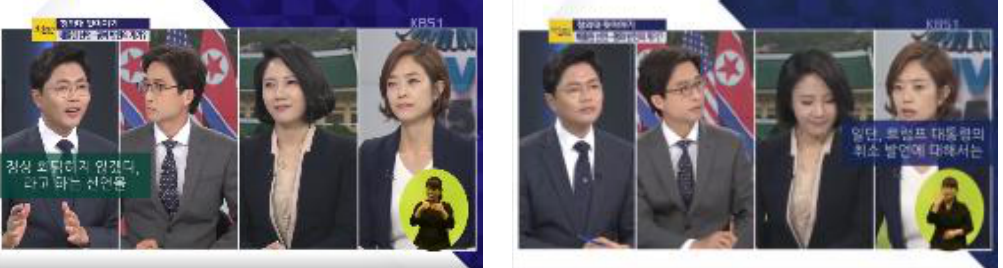
Figure 21. Example of individual subtitles for each speaker.